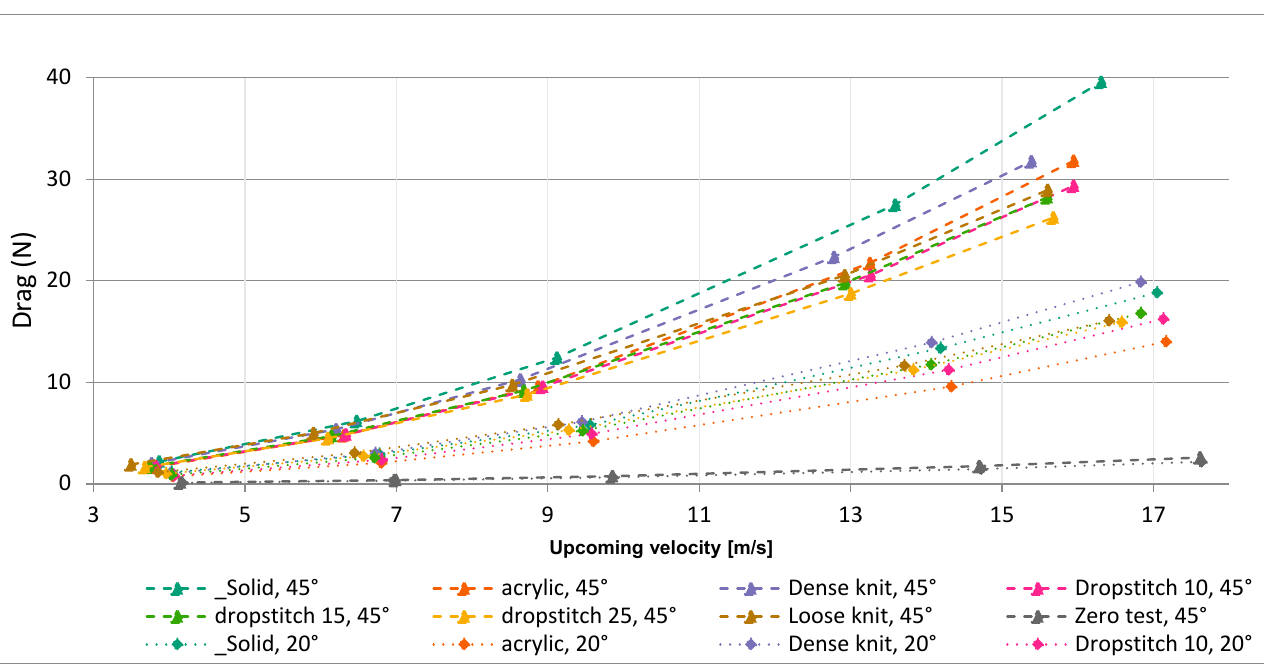
Table 2. Weight of the samples. Model Name